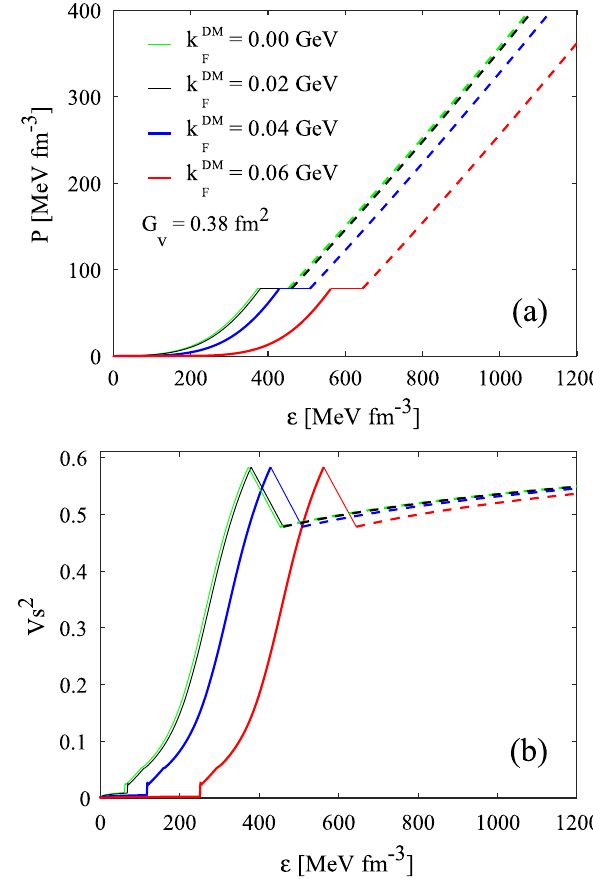
Fig. 1 a Pressure as a function of the energy density of hybrid EoSs using one fixed value for the vector coupling for different values of k DM F constant G V . b Squared sound velocity, v 2 s = ∂ P /∂(cid:14) . Full and